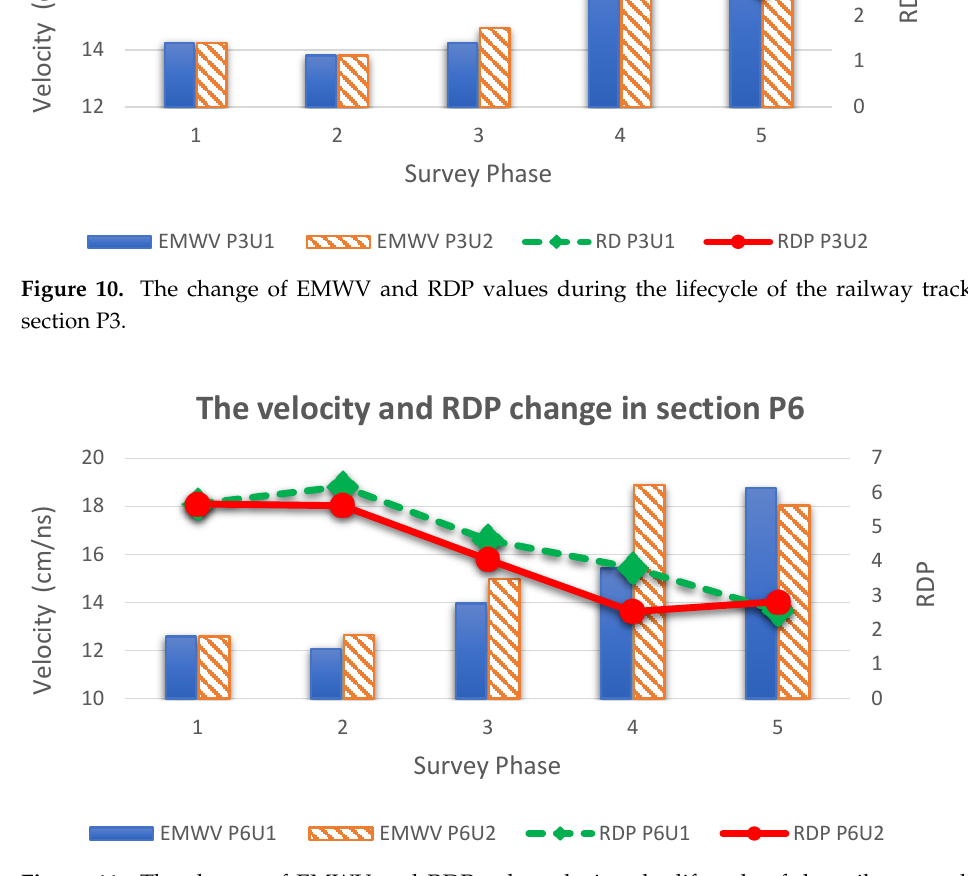
Figure 11. The change of EMWV and RDP values during the lifecycle of the railway track in section P6.